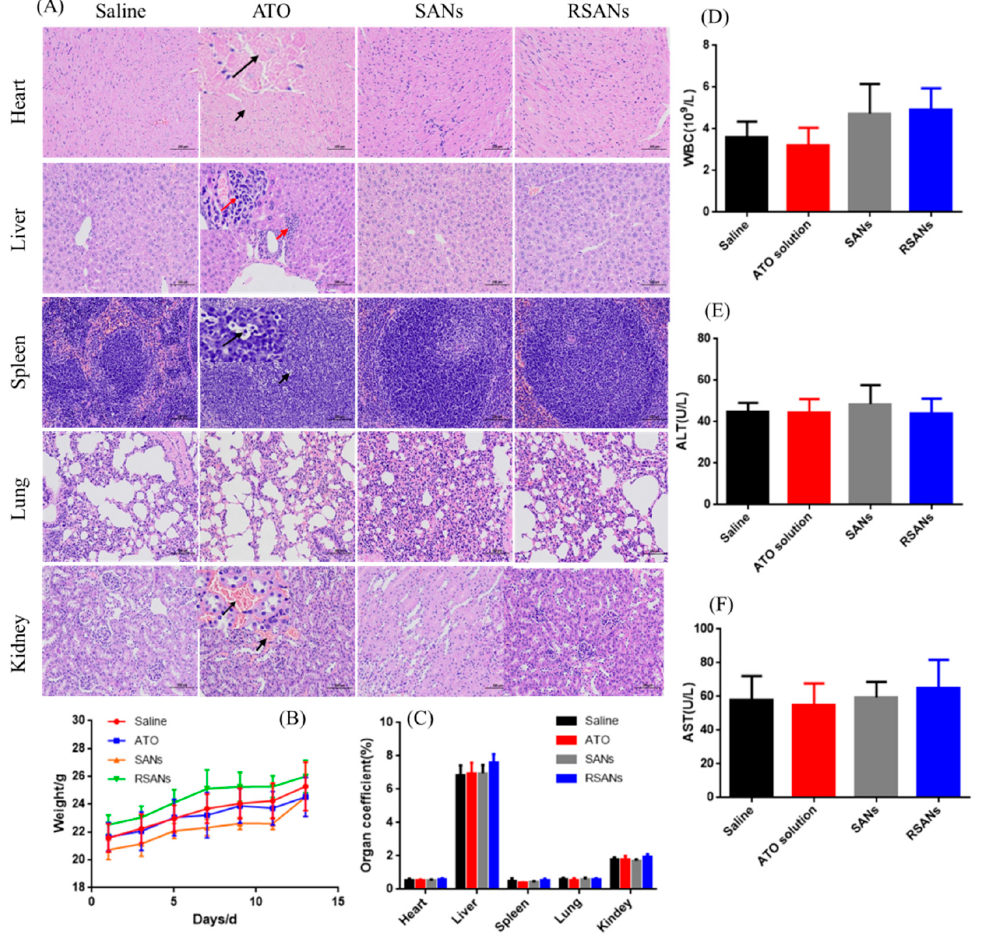
Figure 10. In vivo toxicity and safety evaluation. ( A ) H & E staining of primary organs under 100 µ m. ( B ) Weight changes of nude mice during the experiment. ( C ) Organ coefficients, ( D ) Number of white blood cells, ( E ) ALT, and ( F ) AST of each group at the end of the experiment. Data are shown as ± SD of the mean ( n = 5).